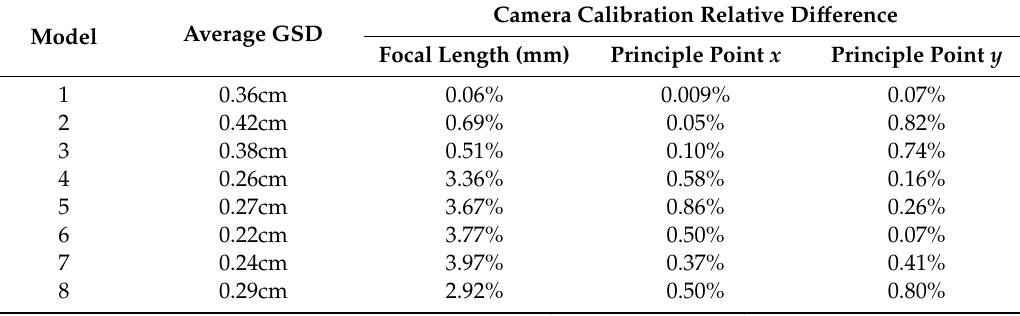
Table 6. Model GSD and camera calibration.